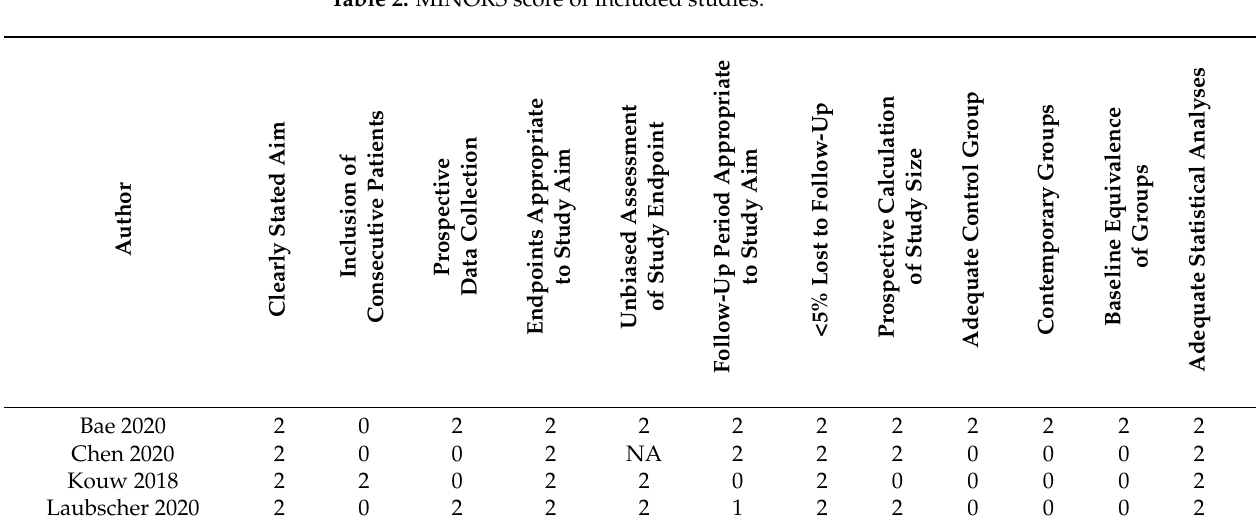
Table 2. MINORS score of included